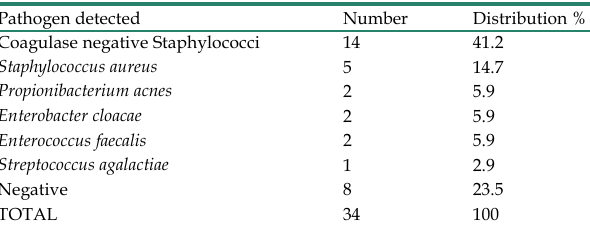
Table 1. Number and distribution of bacteria detected with the Curetis Unyvero ® multiplex PCR (polymerase chain reaction) system in patients with chronic or acute prosthetic joint infection (study groups B and C) Pathogen detected